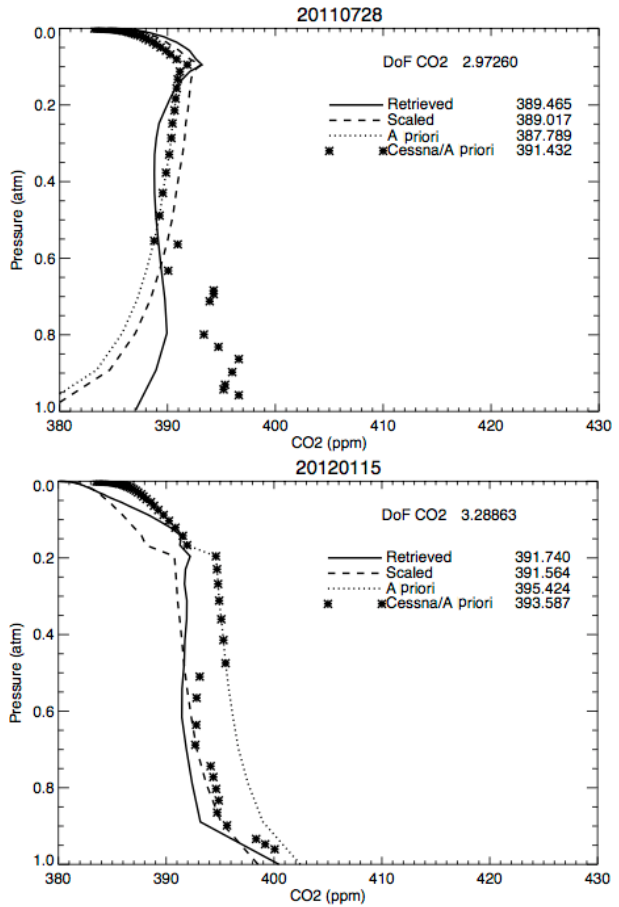
Figure 15. (a) As Fig. 14a but with a different residual basis vector. (b) As Fig. 14b but with a different residual basis